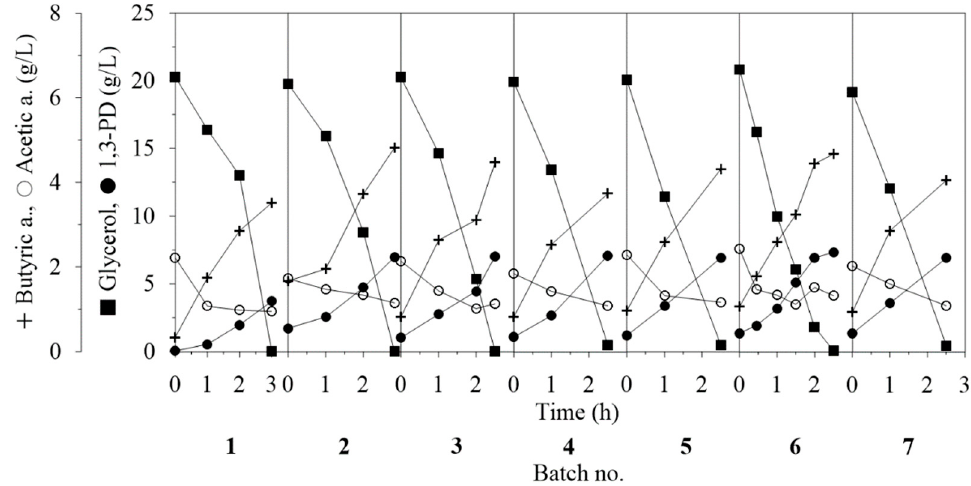
Figure 5. Seven repeated batch fermentations of the UCO-derived crude glycerol (initial concentration: 20.0 ± 0.2 g/L) with the immobilized cells.